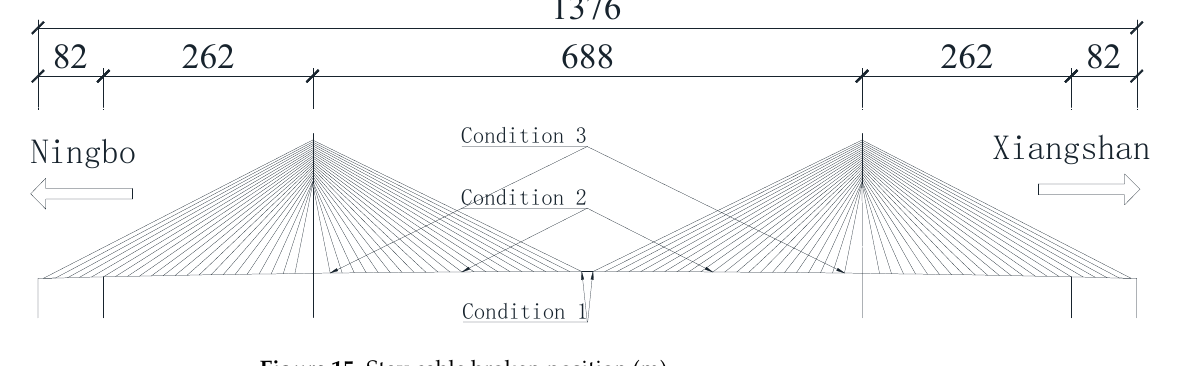
Figure 15. Stay cable broken position (m). Table 3. Aerostatic instability wind speeds under different broken positions of the stay cable. Cable Broken